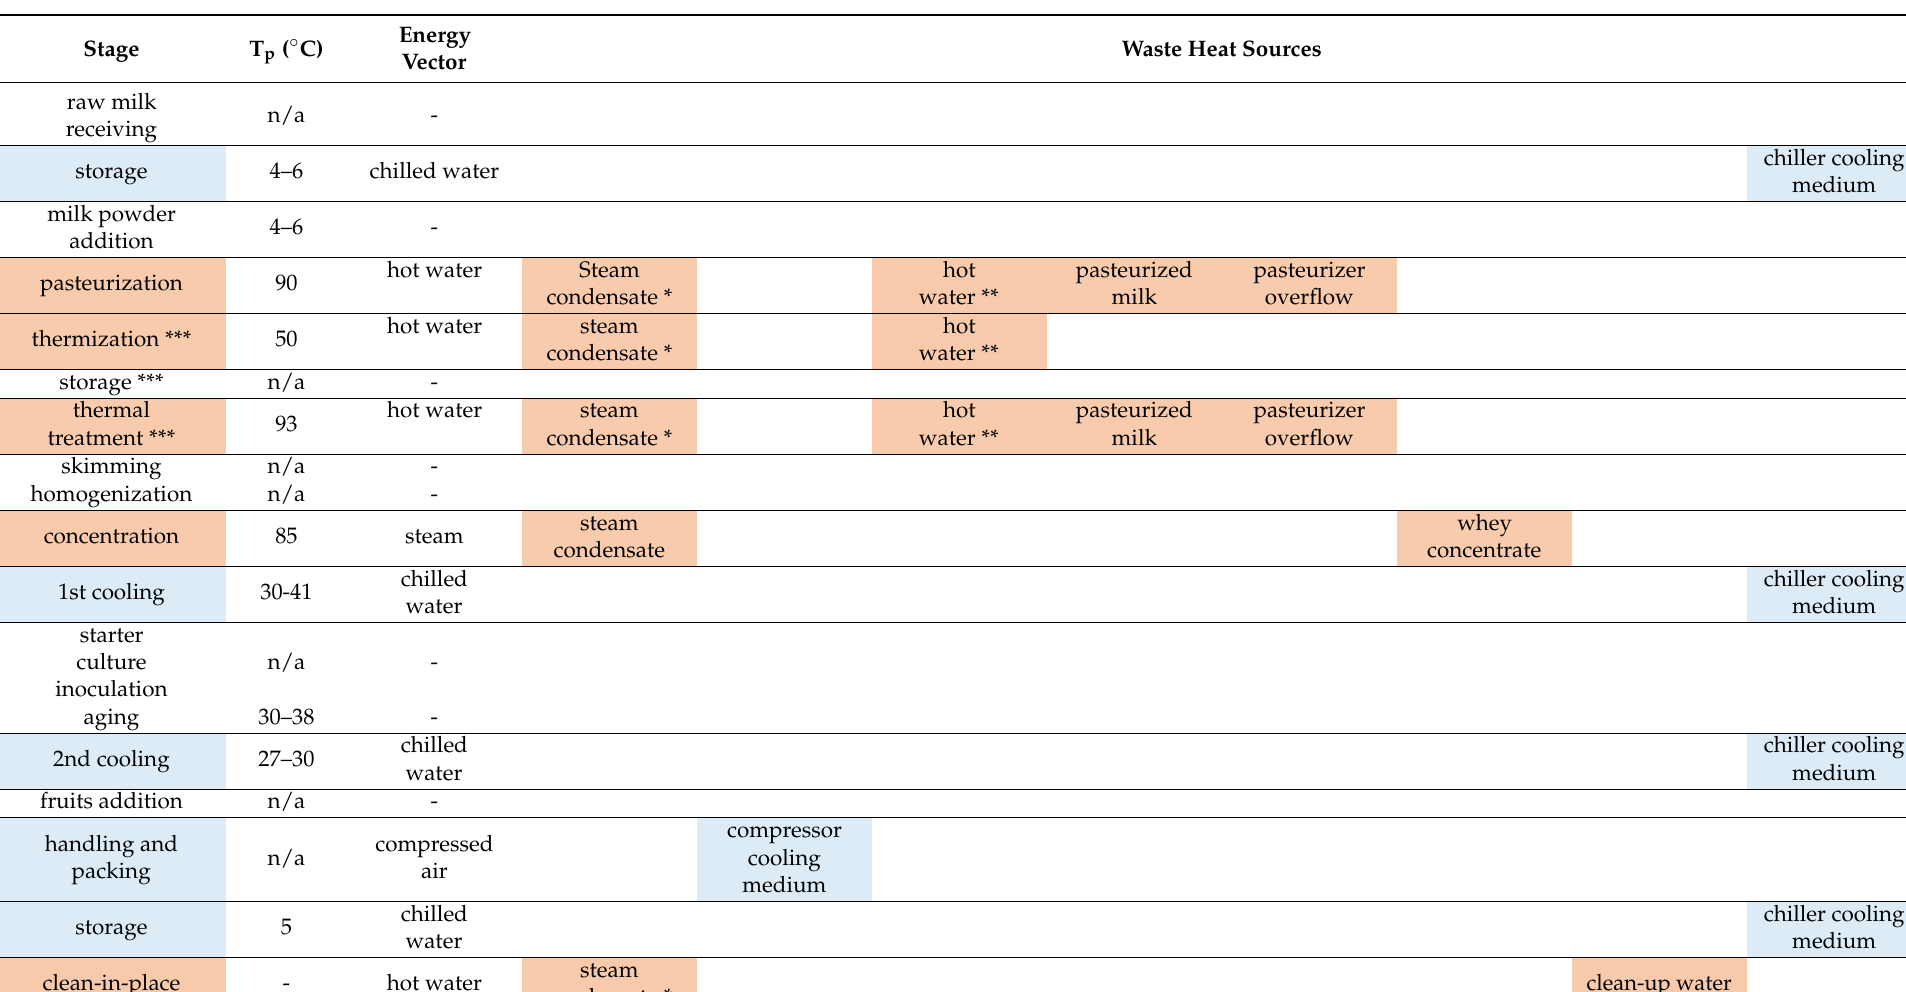
Table A9. Scheme of yoghurt manufacturing process and corresponding low-temperature waste heat